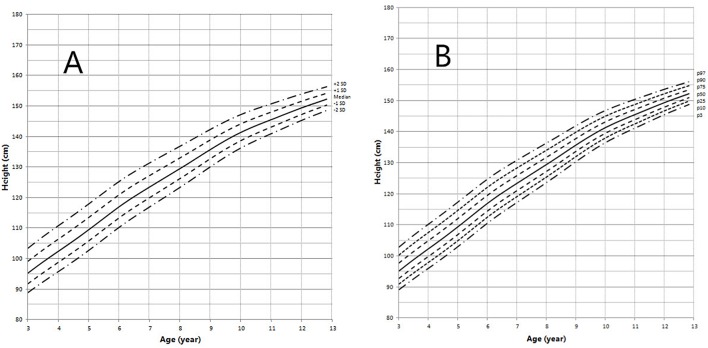
Height in children with 5αRD (3–13 years old). (A) Standard deviation curve; (B) Percentile curve.